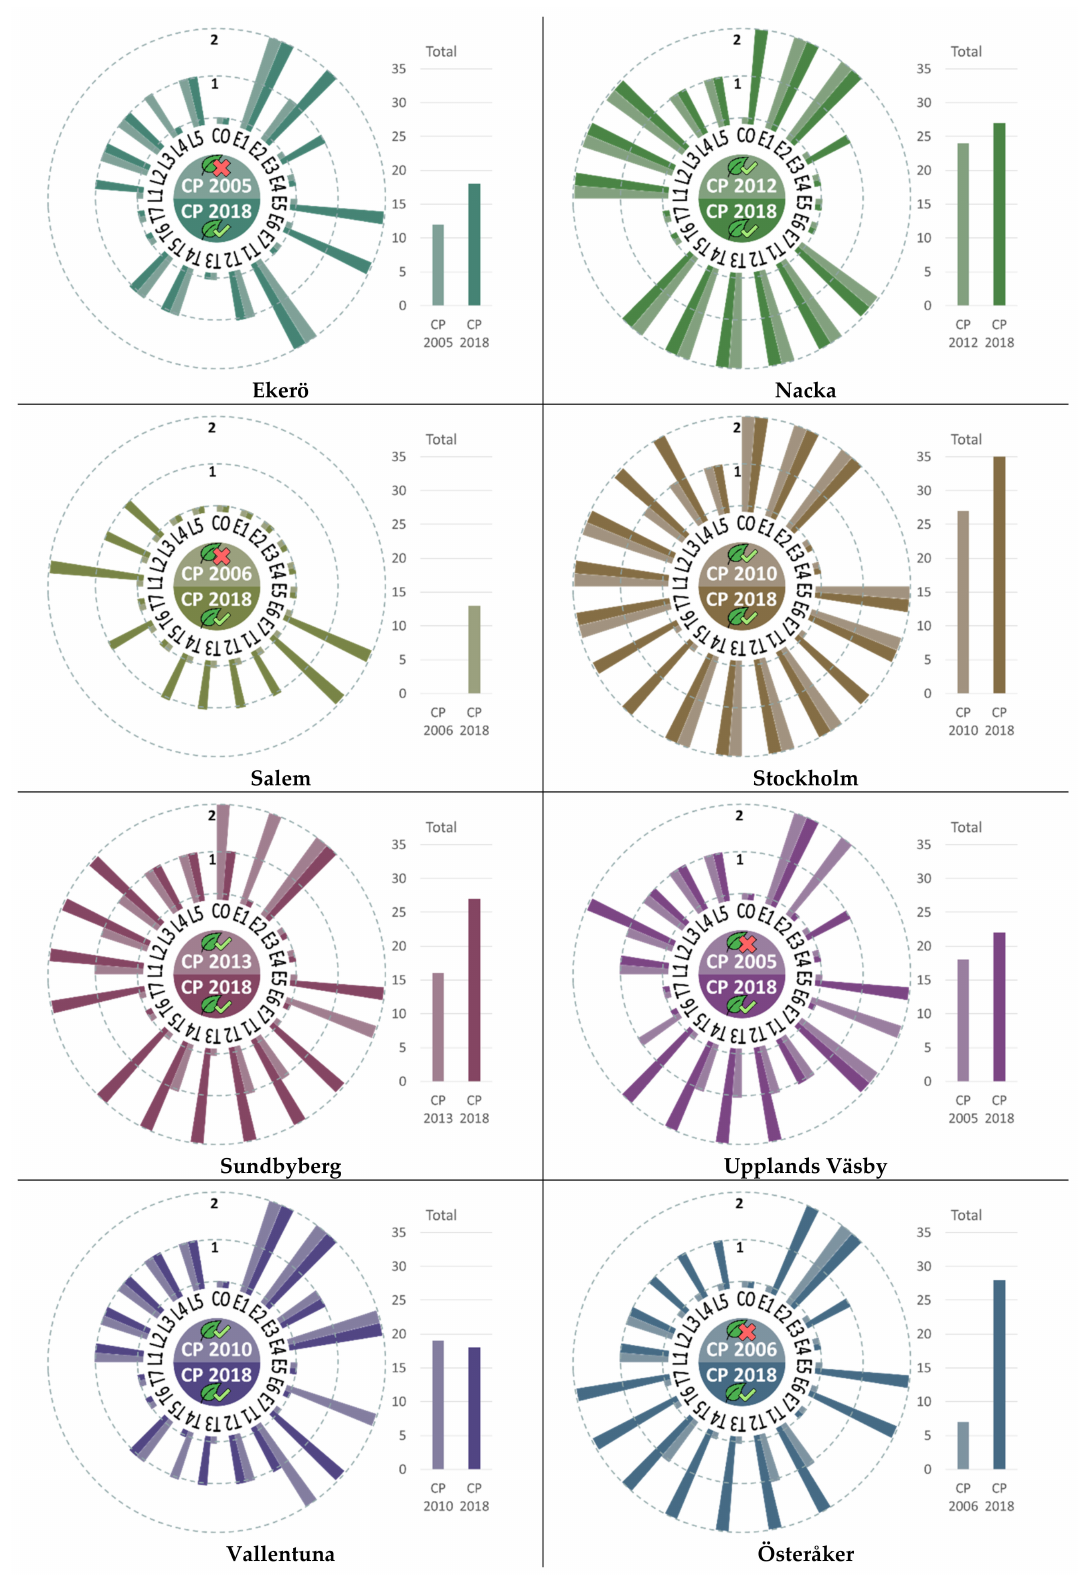
Figure 3. Visualisation of scoring of studied municipal Comprehensive Plans. Explanations of abbreviations are given in Figure 2. The checkmark/cross mark situated adjacent to the year of adoption for each plan indicates whether an environmental report due to the execution of SEA had been identified or